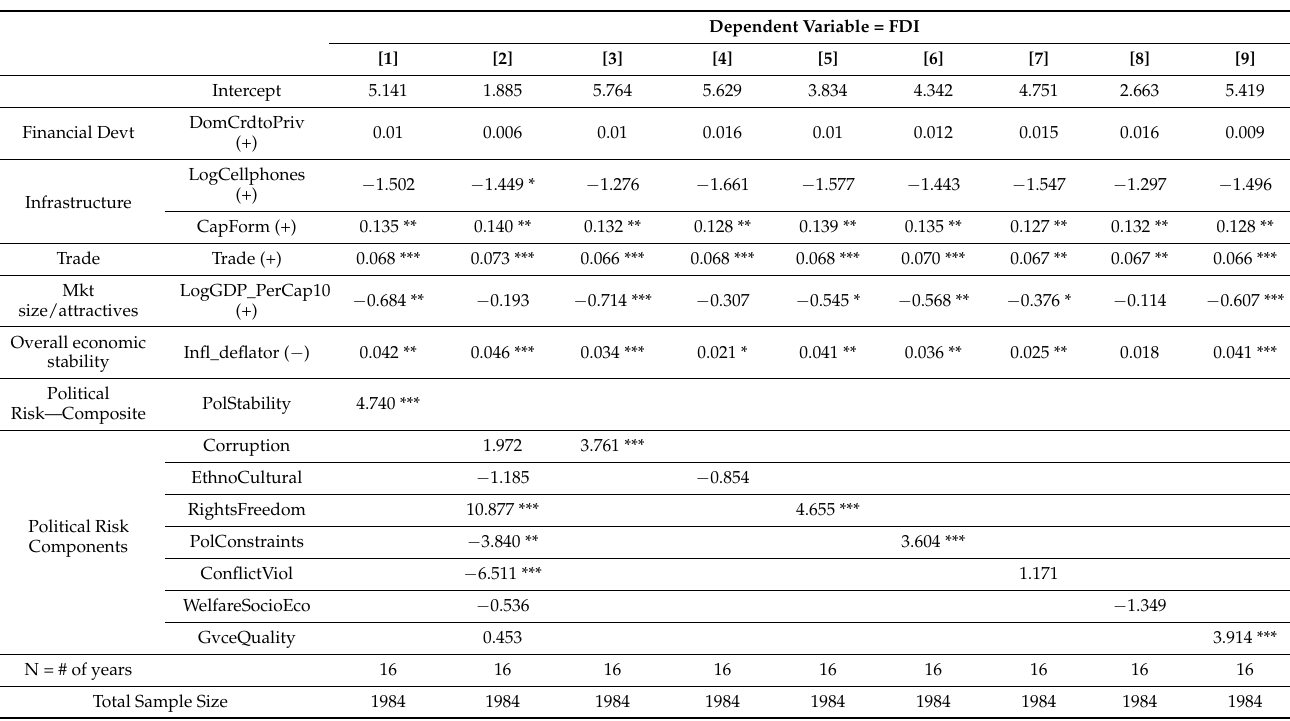
Table 3. Political Risk and